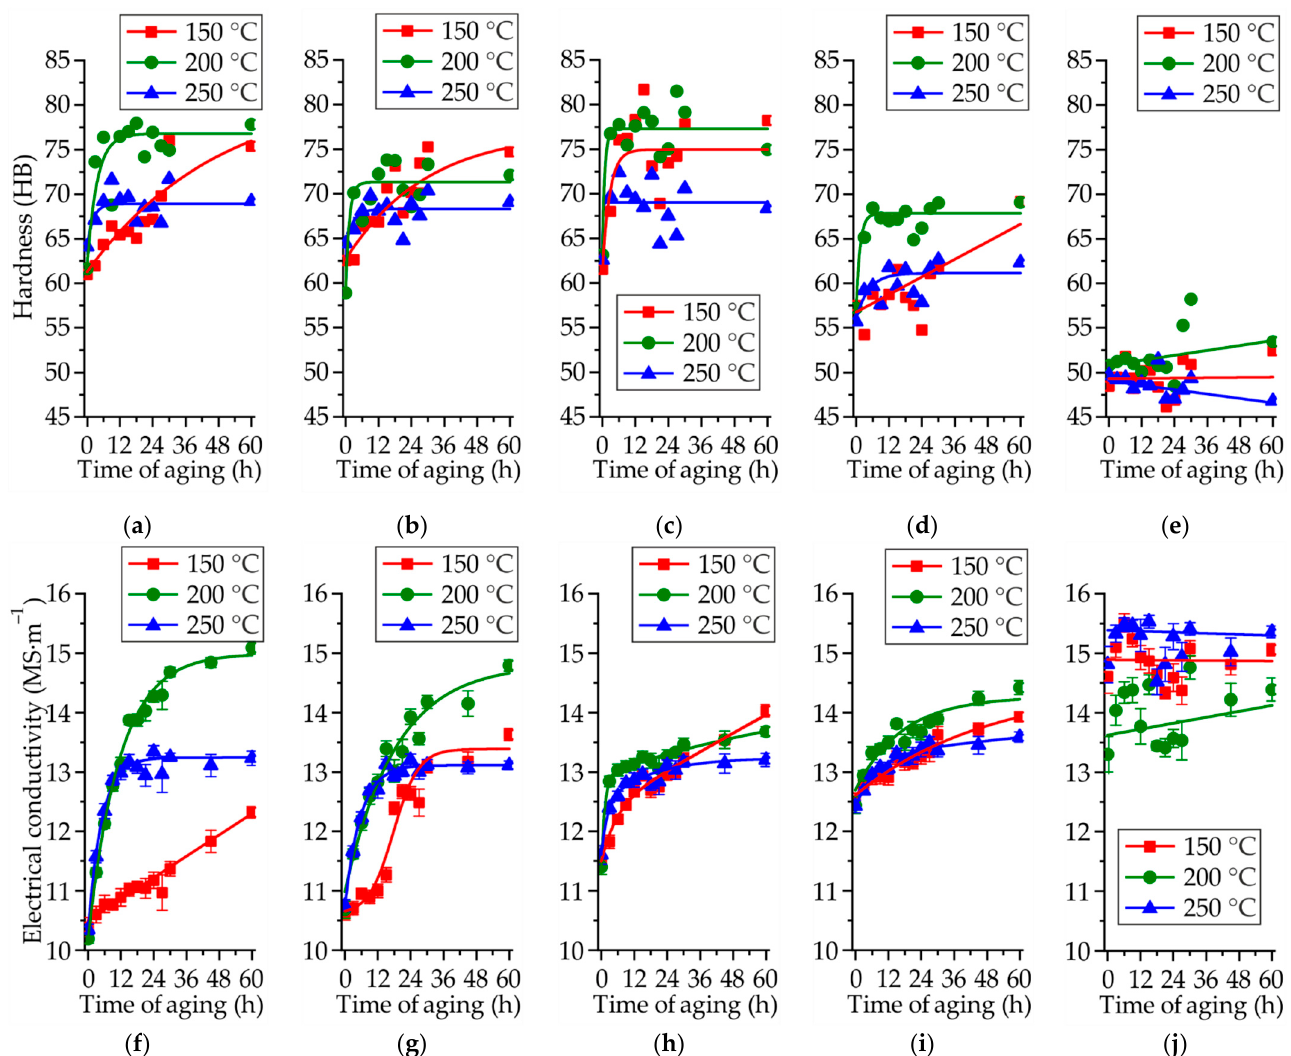
Figure 5. Brinell hardness ( a – e ) and electrical conductivity ( f – j ) of the Mg–Zn–Ga alloys: ( a , f ) MgZn4Ga4, ( b , g ) MgZn4Ga4Y0.5, ( c , h ) MgZn6.5Ga2, ( d , i ) MgZn4Ga2, and ( e , j ) MgZn2Ga2 during aging at different temperatures (18 h at 450 °C for MgZn2Ga2, and 18 h at 350 °C for other alloys) after SSHT.